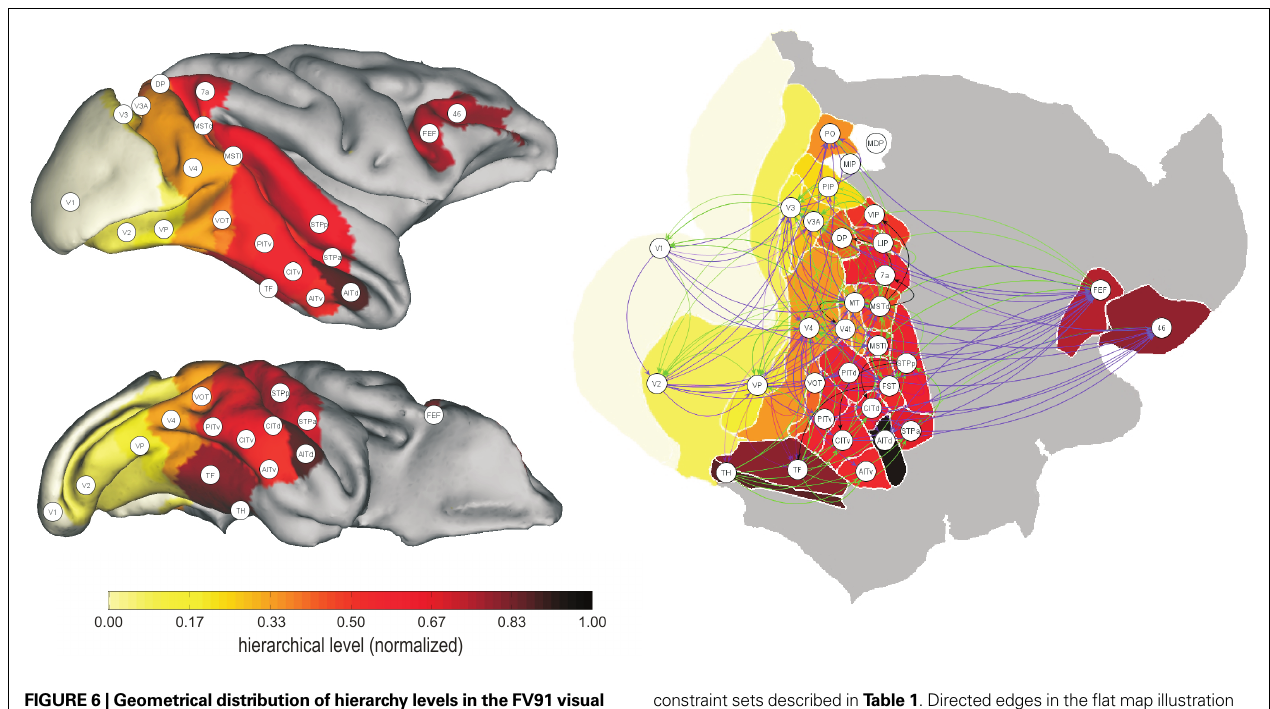
constraint sets described in Table 1 . Directed edges in the fl at map illustration represent interregional connections, and are coloured according to projection class: A + (purple, opaque), A (purple, transparent), L (black), D (green, transparent), and D + (green, opaque). Compare this representation to Figures 2 and 4 in Felleman and Van Essen